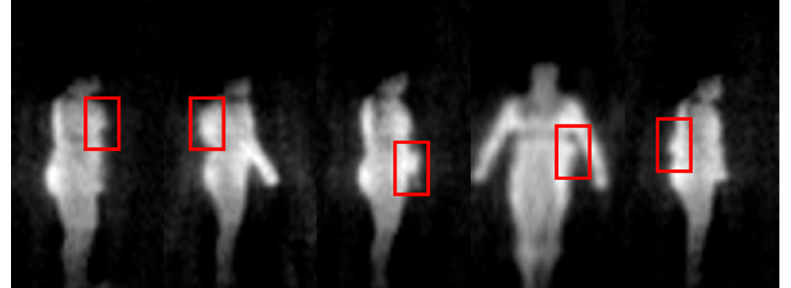
Figure 11. Example of classification dataset. We extracted the threats sub-region from PMMWI as training sample; the left side is the extraction region of the metallic gun, and the right side is the metallic knife.